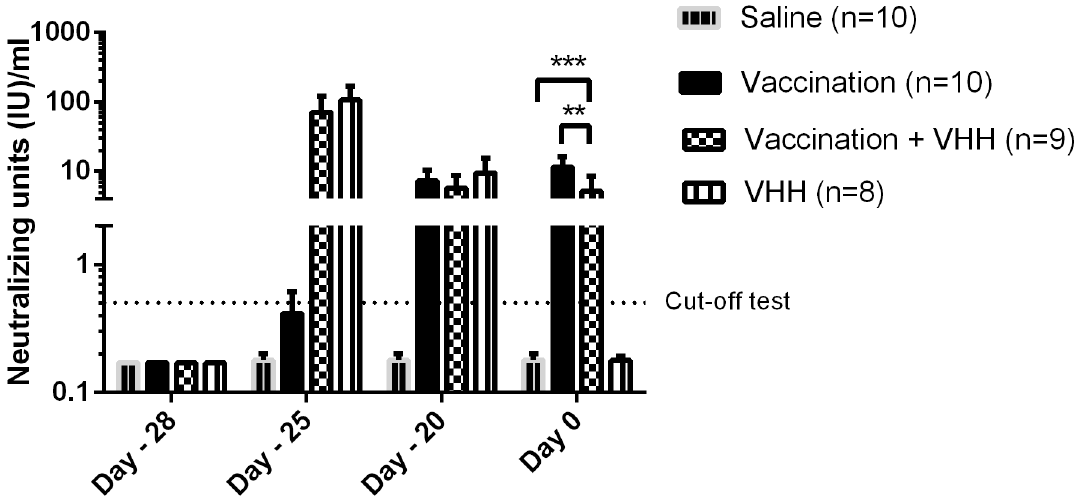
Fig 1. Rabies neutralizing activity in the blood as measured by RFFIT, following intramuscular (IM) vaccination at day -28 and day-25 either alone or in combination with anti-rabies VHH (Rab-E8-H7-ALB11, 1.5 mg/mouse) at day -28. Control groups consisted of mock treatment with saline (0.9% NaCl) or anti-rabies VHH only at day -28. Blood was collected at day -28 (prior to vaccination and VHH administration), day -25, day -20 and day 0 (= time of virus challenge). Both groups of mice that received anti-rabies VHH had high neutralizing titers at the early time points (day -25 and -20). Mice that received vaccine had neutralizing antibodies at day -20, which further increased to high levels at day 0. Mice treated with anti-rabies VHH only no longer had detectable VHH at day 0. Antibody titers in the vaccine + VHH group were significantly lower than in the vaccine only group at day 0 ( ** p < 0.005, *** p < 0.001). Error bars represent the standard deviation.